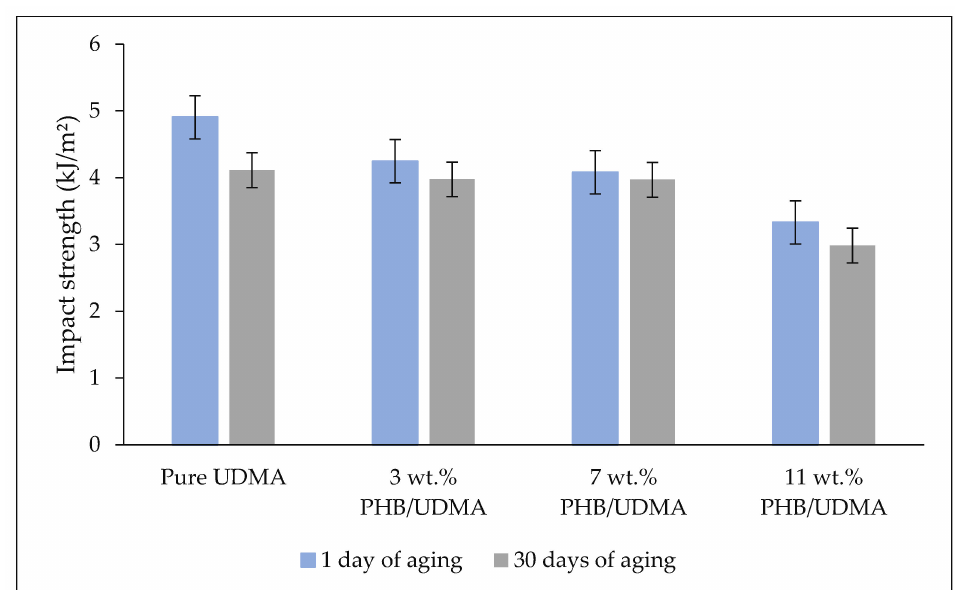
Figure 6. Impact strength of varied 3D printed